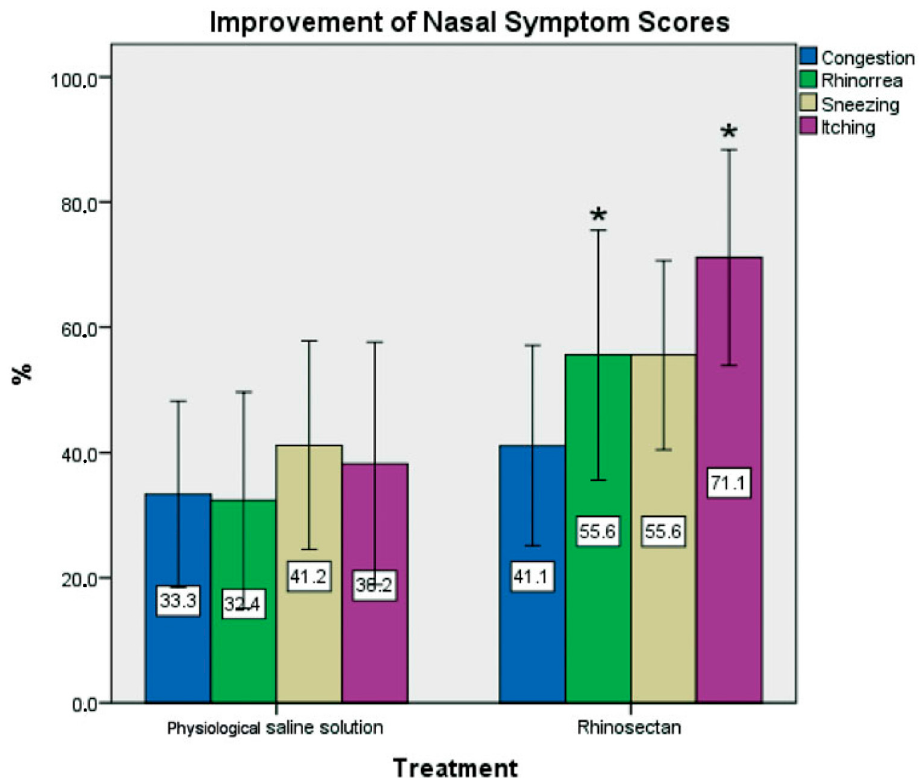
Figure 6. Percentage improvement in individual symptom scores from baseline to the end of treatment (2 weeks) in both groups of patients with rhinosinusitis (acute recurrent or chronic) (Rhinosectan ® and physiological saline spray). Administration consisted of two sprays per nostril four times